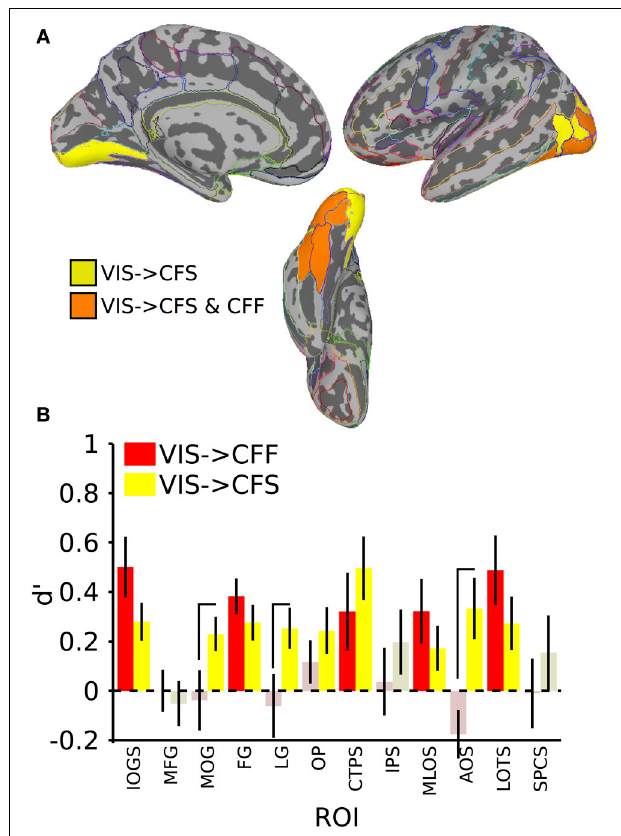
FIGURE 4 | Results for classification from visible to invisible presentation methods. (A) Colored anatomical ROIs indicate regions where category classification was significantly above-chance ( p < 0 . 05 FDR-corrected) when performing cross-method category classification from visible to either invisible presentation methods. (B) Bar graphs of all regions where significant cross-method category classification was possible. Full region names for the ROI abbreviations are found in Table 2 . Saturated (yellow and red) colors indicate significant classification, whereas desaturated (light red, light green) colors indicate non-significant